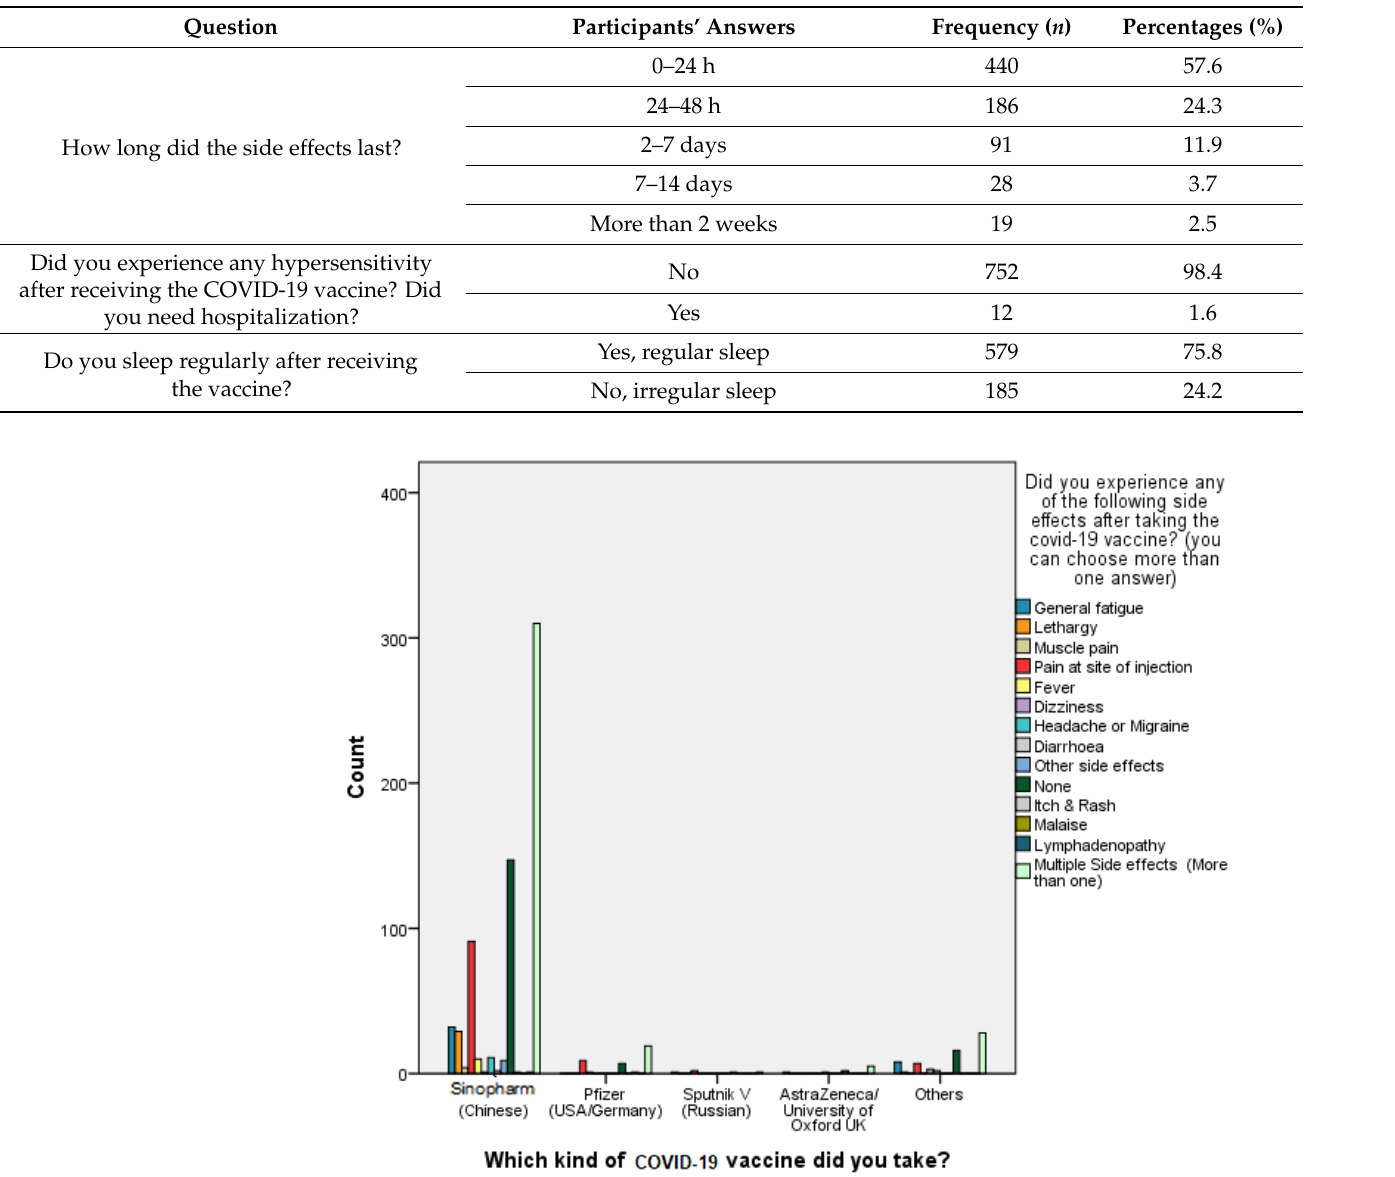
Figure 1. Reported side effects of different vaccines. Using basic descriptive statistics, variation between males and females in terms of rating the severity of the vaccines’ side effects revealed that female participants had a higher mean score than males (2.11 vs. 1.74) Similarly using a Mann–Whitney test, it was found that females had a mean rank of 402.66, while males had a mean rank of 326.03, which is considered statistically significant as the p -value (two-tailed) was found to be <0.0001. Likewise, as presented in in Table 7, using a chi-square test, out of all the respondents, the females were found to be more susceptible to the adversities of COVID-19 vaccination ( p < 0.001), with multiple (more than one side effect in one individual) side effects of slight severity ( p < 0.001) (Figure